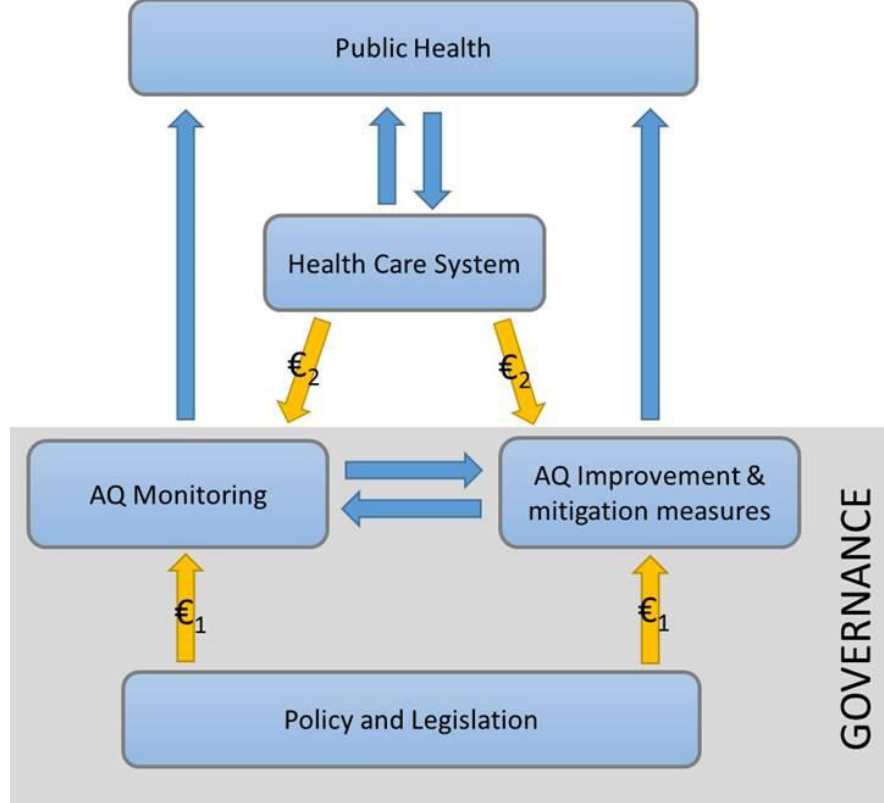
Figure 1. The interplay of air quality (AQ) monitoring and AQ improvement and mitigation measures, paid out of common assets (€1), adds to improved public health. The necessary measurement networks and intervention strategies could, therefore, be funded from the savings that were generated in the healthcare system (€2), gradually phasing out the necessity of a contribution from common assets.